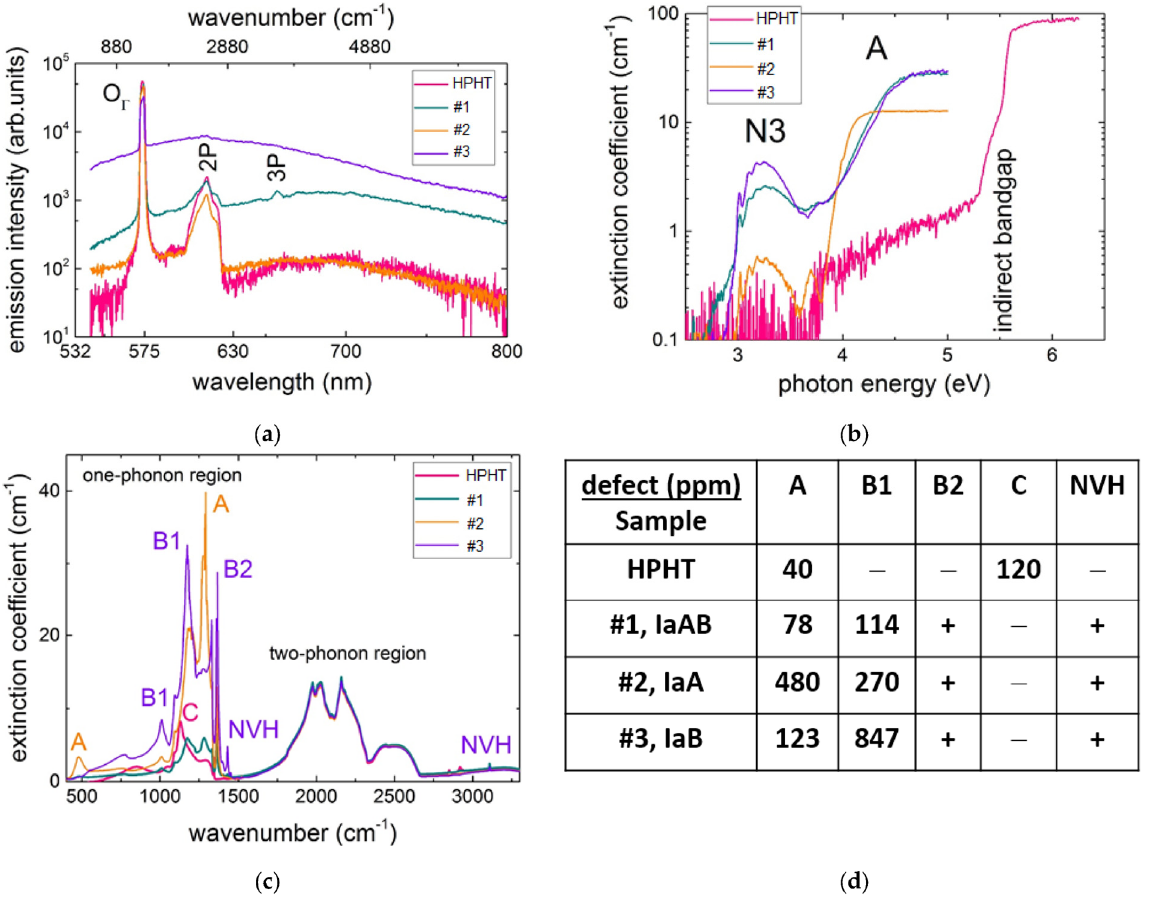
Figure 2. Characteristic spectra of diamonds IaAB, IaA, and IaB (#1–#3): ( a ) PL spectra at 532 nm excitation wavelength (spectral assignment after [60]); ( b ) UV-NIR optical density spectra, revealing main intra-gap absorption features (spectral assignment after [60]); ( c ) FT-IR absorbance spectra (spectral assignment after [60]); ( d ) abundance of different nitrogen-based defects (optical centers), according to FT-IR analysis.